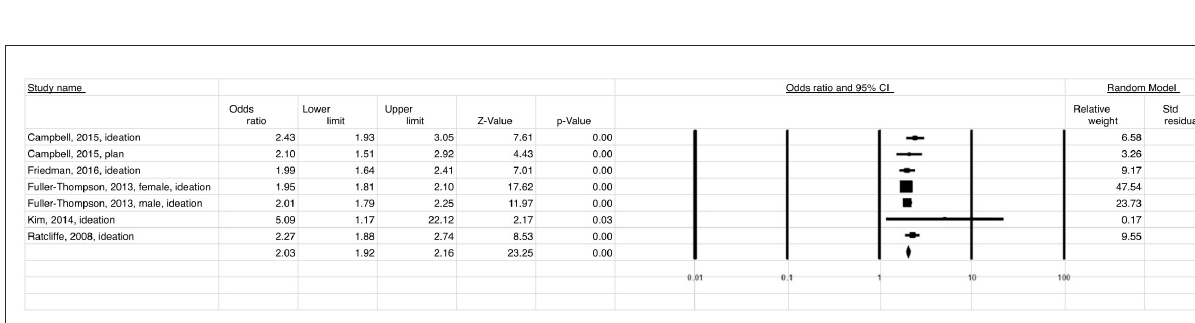
FIGURE4 Relationship between the risk of suicide ideation/planning (OR = 2.03) in patients with migraine when compared to healthy controls.